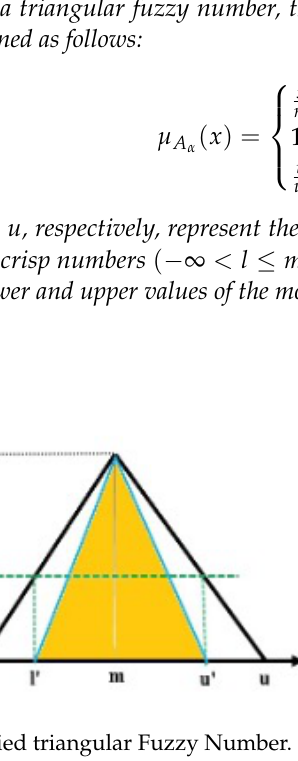
Figure 2. Modified triangular Fuzzy